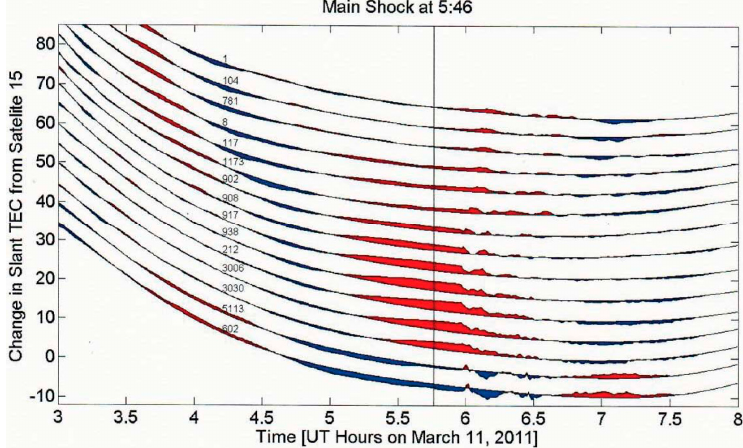
Figure 1. Total Electron Context (STEC) time series from fifteen ground stations and Satellite 15. The ground station numbers are listed at the left and time of the quake is indicated by the vertical line. Red fills correspond to STEC enhancements and blue fills to STEC depressions. (After Kelley et al. 2017 [7], reproduced with permission of the American Geophysical Union).